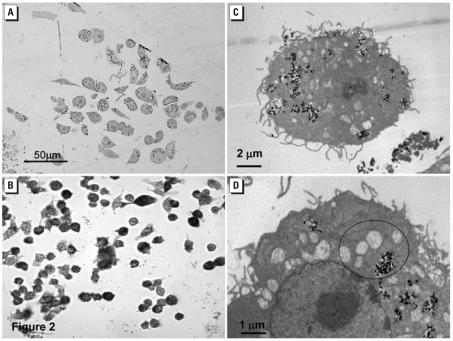
BV2 microglia exposed to P25 (20 ppm) were examined with both LM and TEM. (A) The toluidine blue stained cytoplasm of BV2 microglia housed numerous, light-refractive P25 aggregates after 3-hr exposure. (B) LM examination of unstained, fixed cells exposed to P25 for 48 hr indicated that the cellular membranes were fragmented and showed granular cytoplasm and centralized nuclei. Magnification × 1,200. (C) TEM examination of the P25 exposed BV2 microglia indicate phagocytic internalization of the P25 aggregates after 3 hr. (D) Higher magnification of the BV2 microglial cytoplasm indicated swollen and disrupted mitochondria (circles) in proximity to the P25 aggregates.